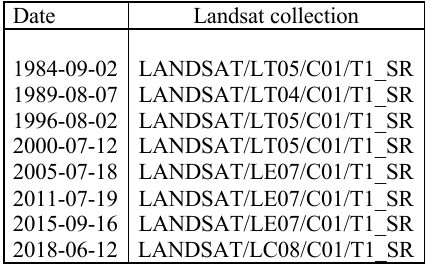
Table 2. Landsat image composites and used collections (Landsat imagery courtesy of US Geological Survey).